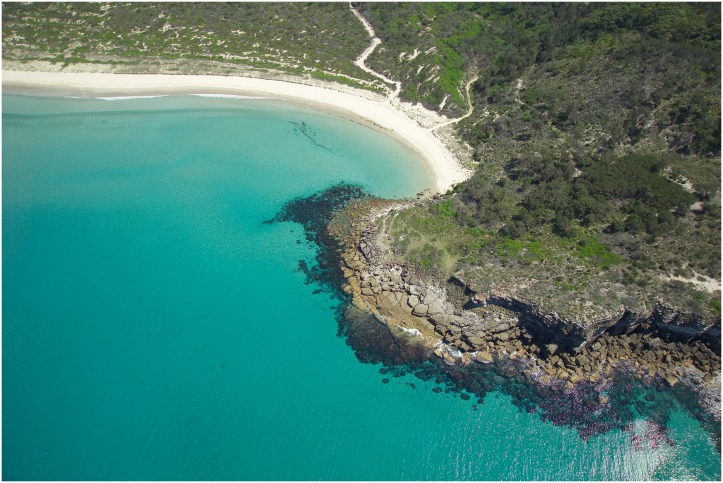
Lines of Bitou Bush (emerald green) deliberately planted to stabilise the foredunes on Bherwerre Peninsula and Beach in BNP.The planting occurred long before Bitou Bush was declared an environmental weed in Australia. (Photo from BNP Archive).